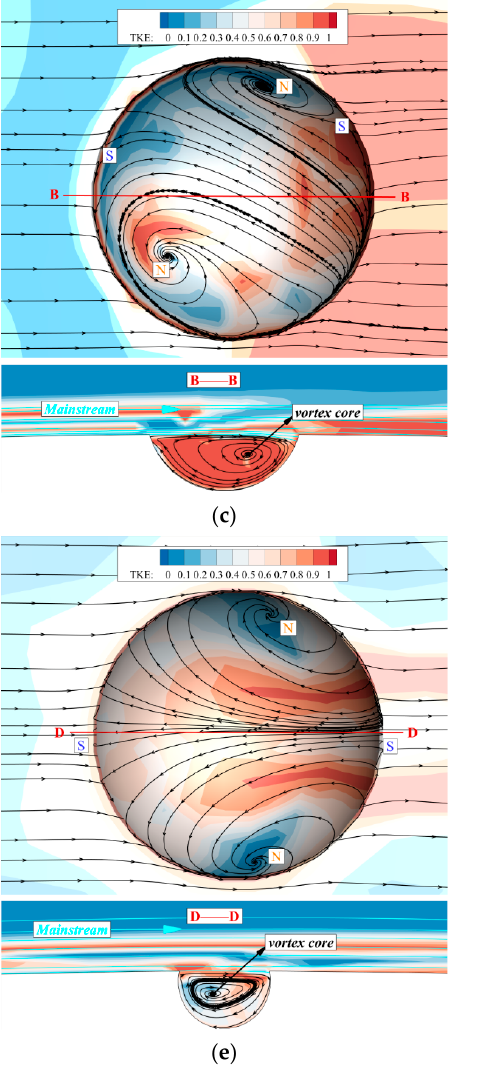
Figure 17. Normalized turbulent kinetic energy ( TKE ) distribution on suction surface and flow in- side the dimple. ( a ) Normalized TKE and axial vorticity on suction surface ; ( b ) 𝜆 = 0.125 ; ( c ) 𝝀 = 0.375 ; ( d ) 𝜆 = 0.5 ; ( e ) 𝜆 = 0.625 ; ( f ) 𝜆 = 0.875 . ( d ) λ = 0.5; ( e ) λ = 0.625; ( f ) λ = 0.875. Table 4. Flow regime corresponding the parameter of dimple.